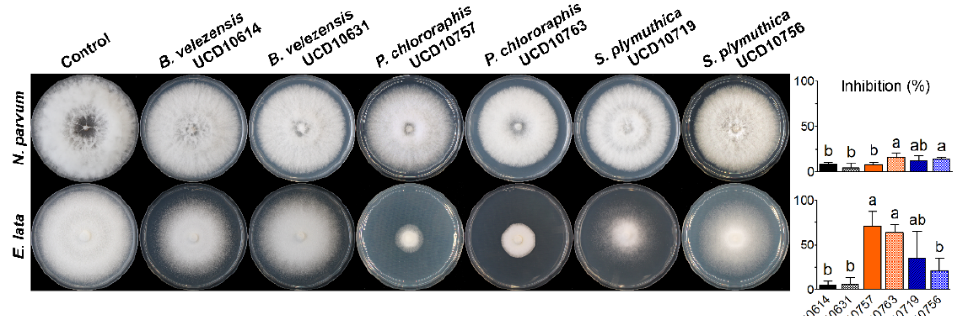
Figure 8. Inhibition levels (%) of volatile organic compounds (VOCs) produced by selected isolates of B. velezensis , P. chlororaphis and S. plymuthica against the mycelial growth of N. parvum (top) and E. lata (bottom). On each graph, means with the same letter horizontally are not significantly different from each other according to the Fisher’s LSD test ( p > 0.05).